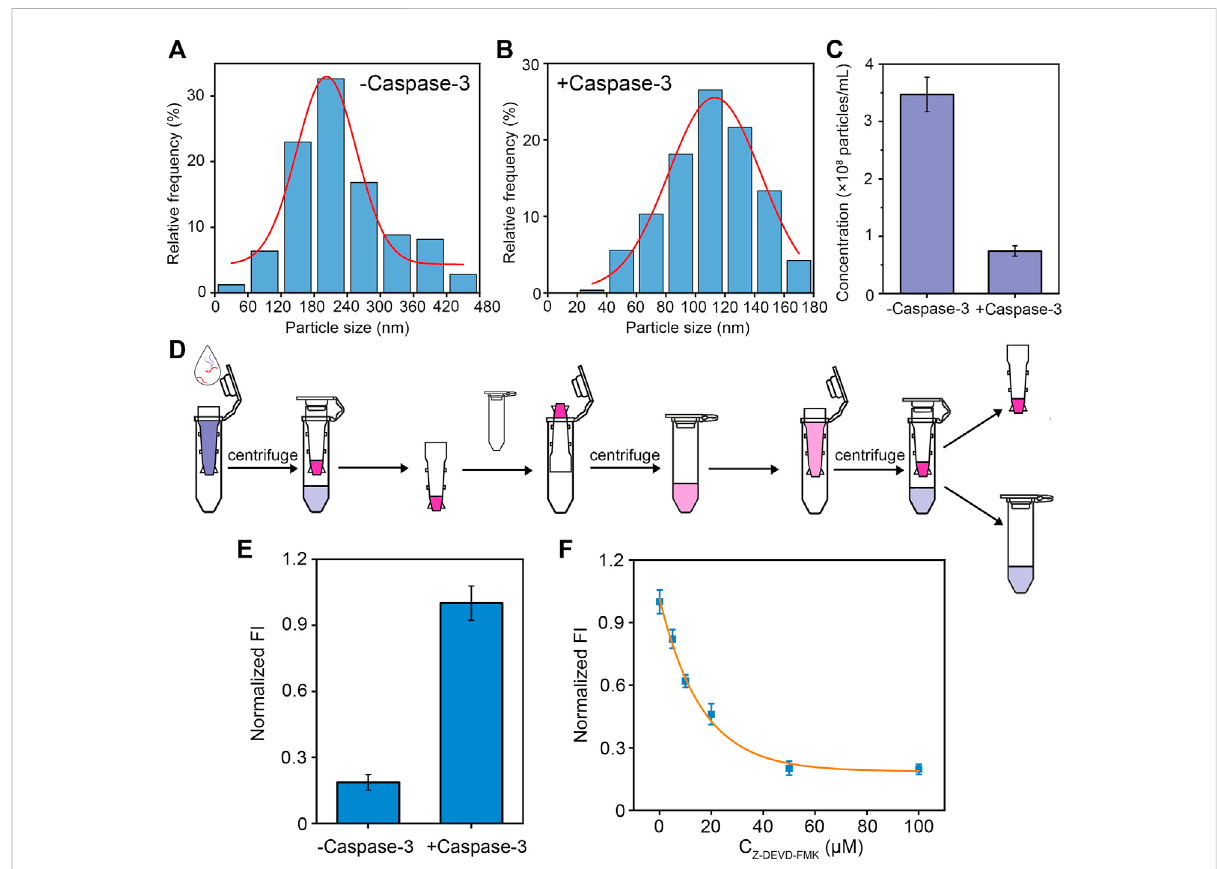
FIGURE 2 Validation of caspase-3 digestion. (A,B) NTA characterization of particle size distribution of bio-nanomicelles assembled. Before and after digestion of caspase-3. (C) NTA characterization of particle concentration of bio-nanomicelles before and after digestion of caspase-3. (D) Schematic diagram of detecting fl uorescence intensity of bio-nanomicelles before and after digestion of caspase-3. (E) Fluorescent detection of bio-nanomicelles before and after digestion of caspase-3. Excitation and emission wavelength of FAM is 492 and 522 nm. (F) Relationship between inhibitors of different concentrations of caspase-3 and fl uorescence intensity of